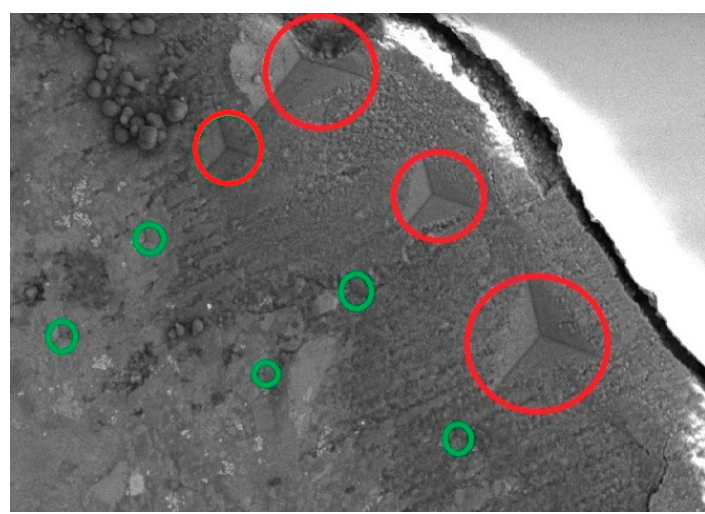
Figure 15. An SEM image of the imprints during the nanoindentation test (Reprinted with permission from [90]. Copyright 2018 Elsevier ).